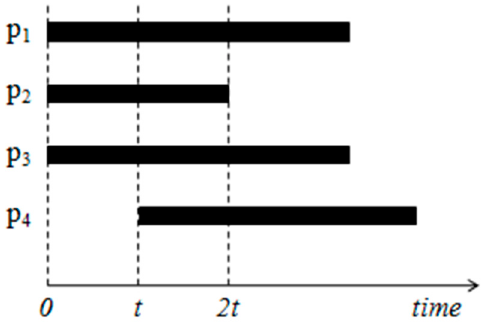
Figure 2. An example of data stream.